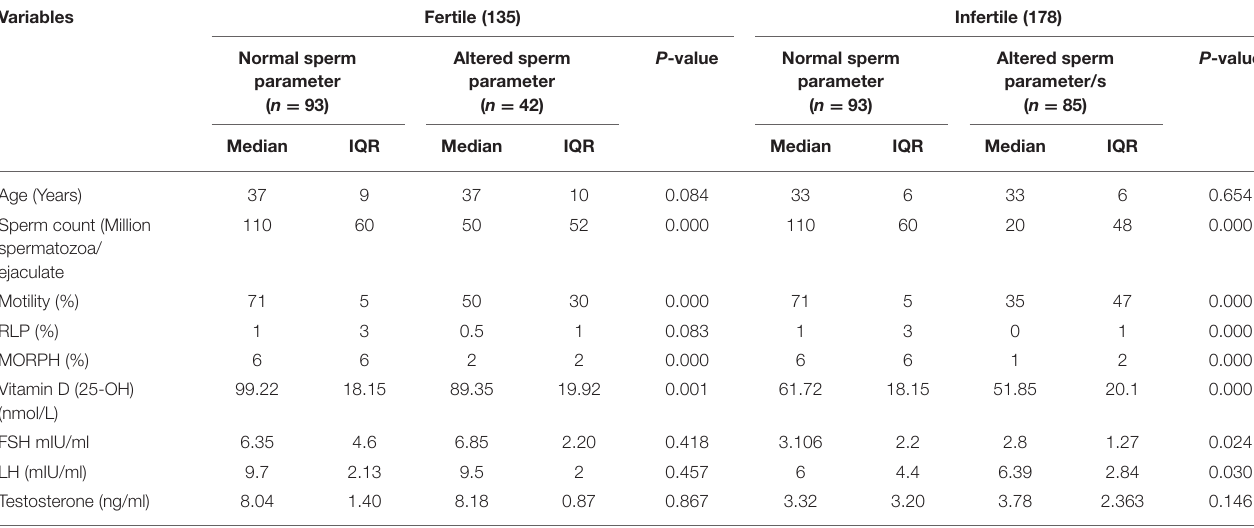
TABLE 1B | Comparison of fertile and infertile subgroups having “normal” and “altered sperm parameters.” Variables Fertile (135) Infertile (178) P -value Normal sperm Normal sperm Altered sperm parameter parameter ( n = 93) ( n = 42)